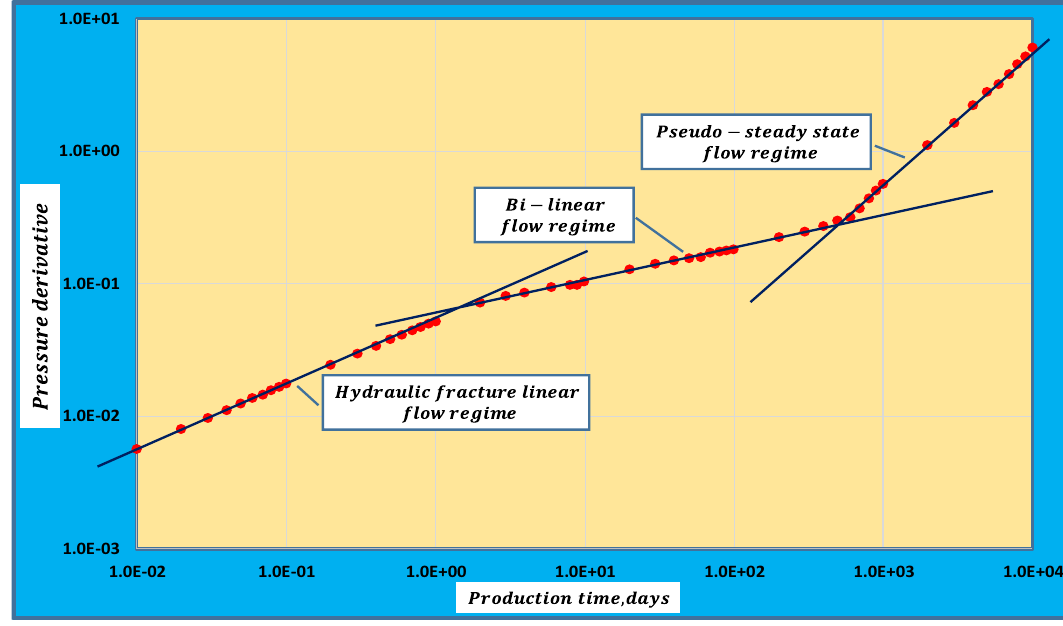
Fig. 31 The flow regimes of the field example shown by the wellbore pressure